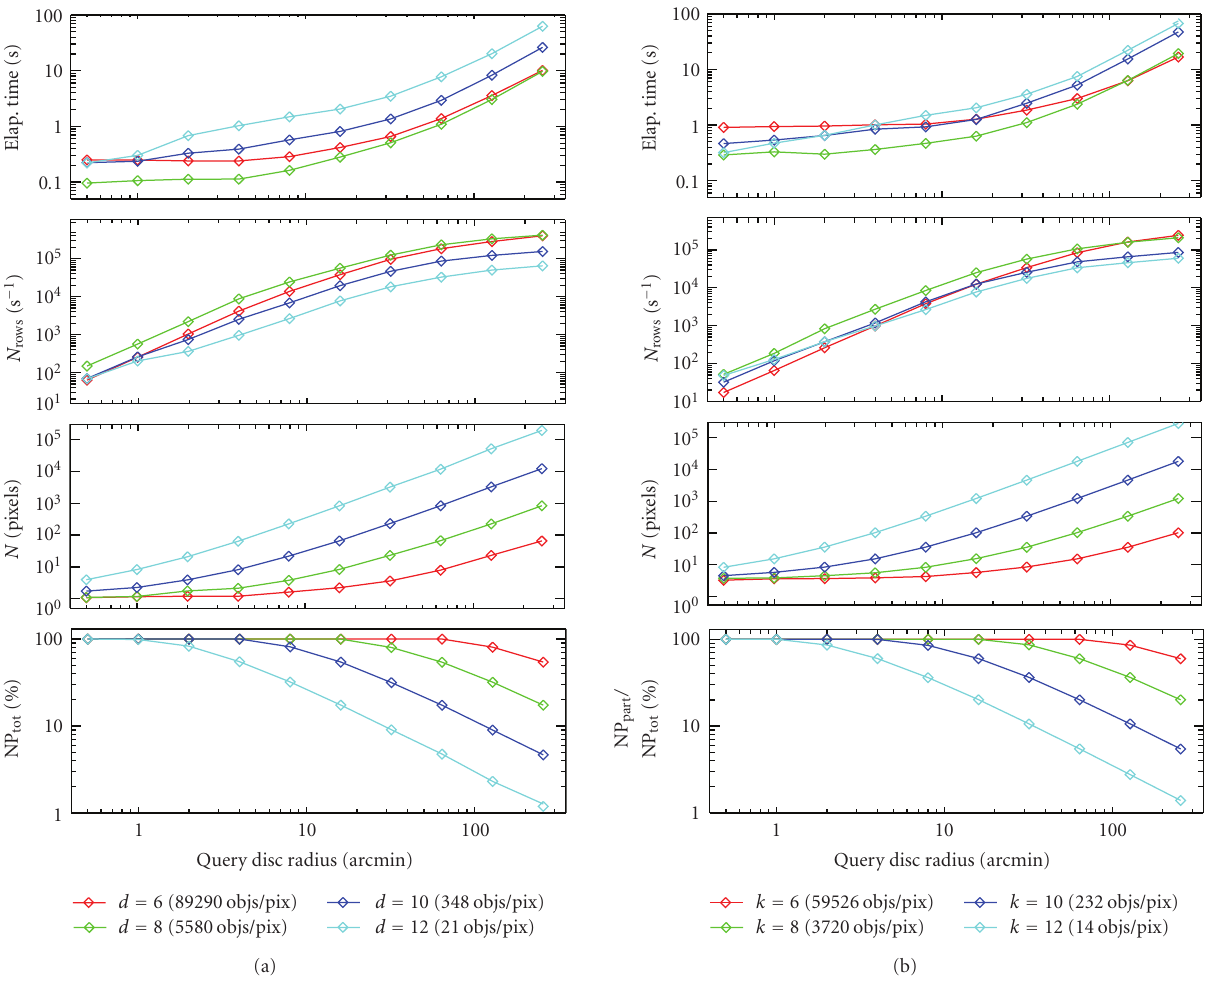
Figure 3: Select query execution times and other parameters for a DIF-managed table with ∼ 3 billion entries as a function of the disc radius. Results for four di ff erent pixel scales are reported both for HTM (a) and HEALPix (b). Each point represents the average of the results from 50 queries performed on random sky